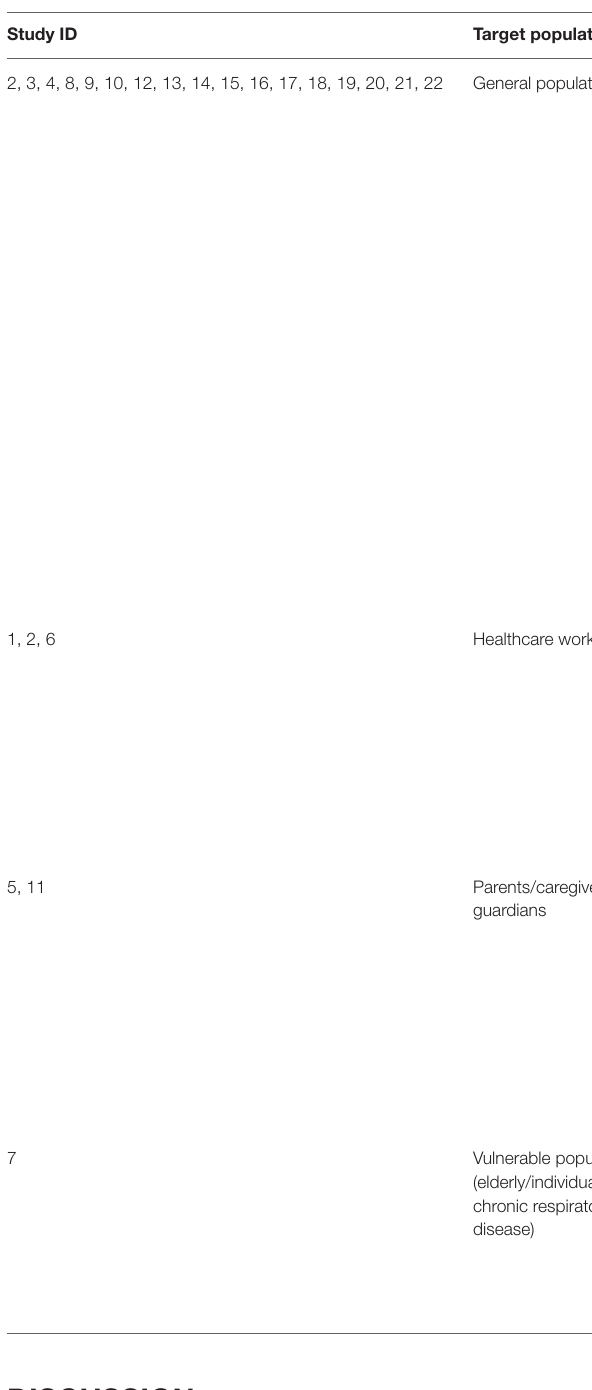
TABLE 5 | Detailed key findings of the included studies according to the target